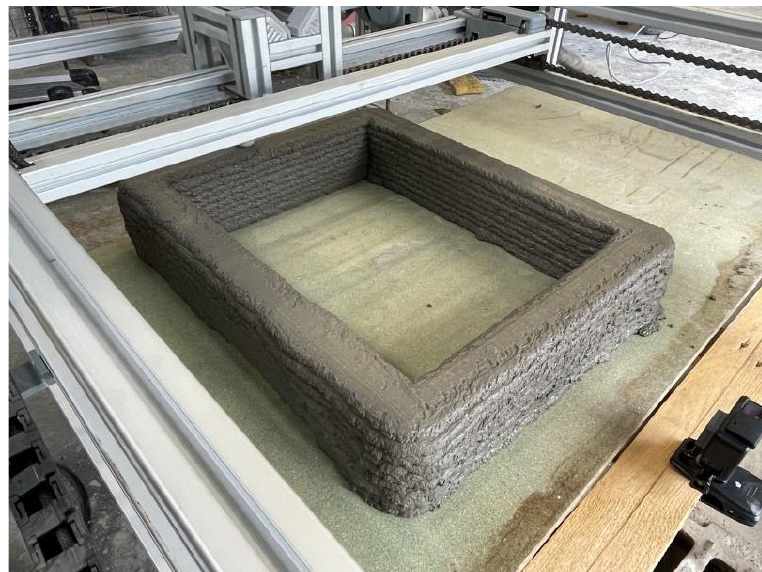
Figure 7. FS10 mixture printed using the gantry printer.